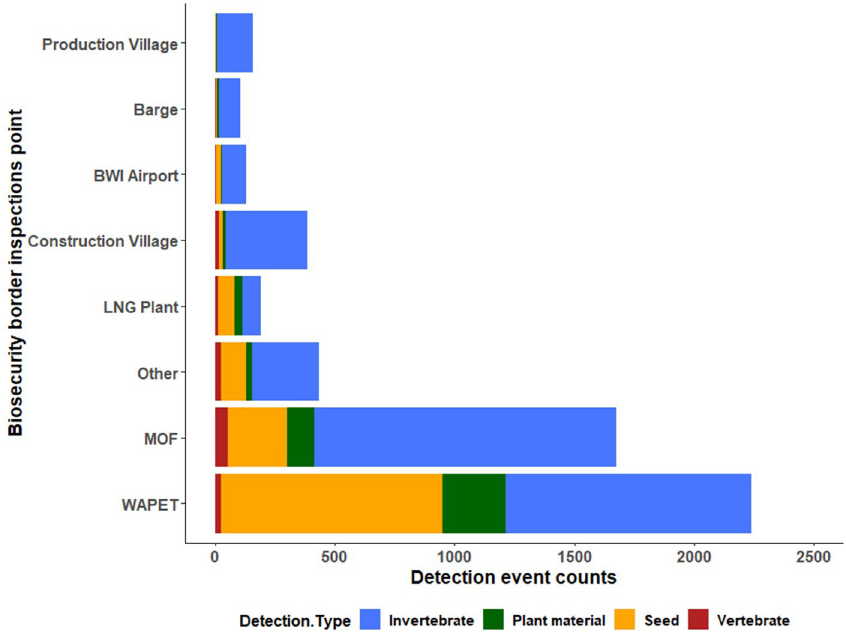
Fig 2. Comparison of biosecurity border inspection detections by physical border entry location for Barrow Island from 2009 to 2015. NB: Others included Barrow Island shore waters and pre-commissioning sites.